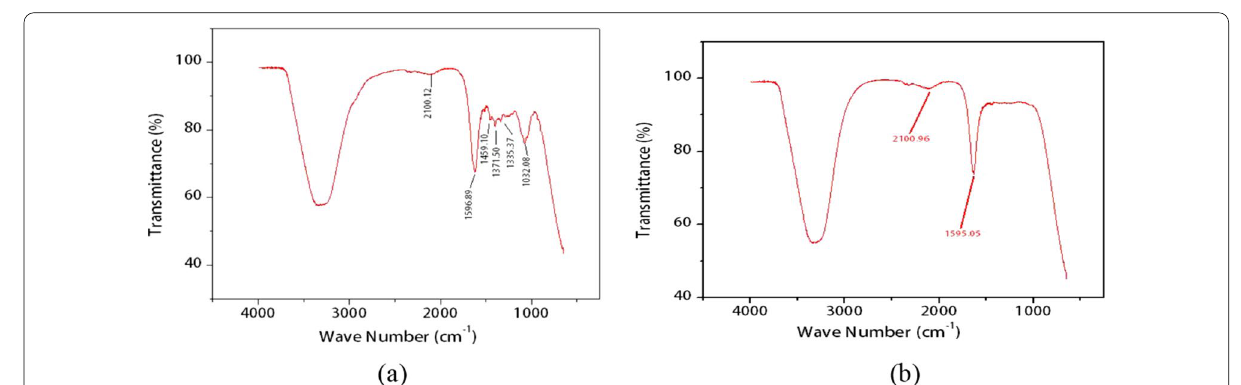
Fig. 2 FT‑IR spectrum a for Grewia asiatica L . leaves extract, b biosynthesized copper nanoparticles